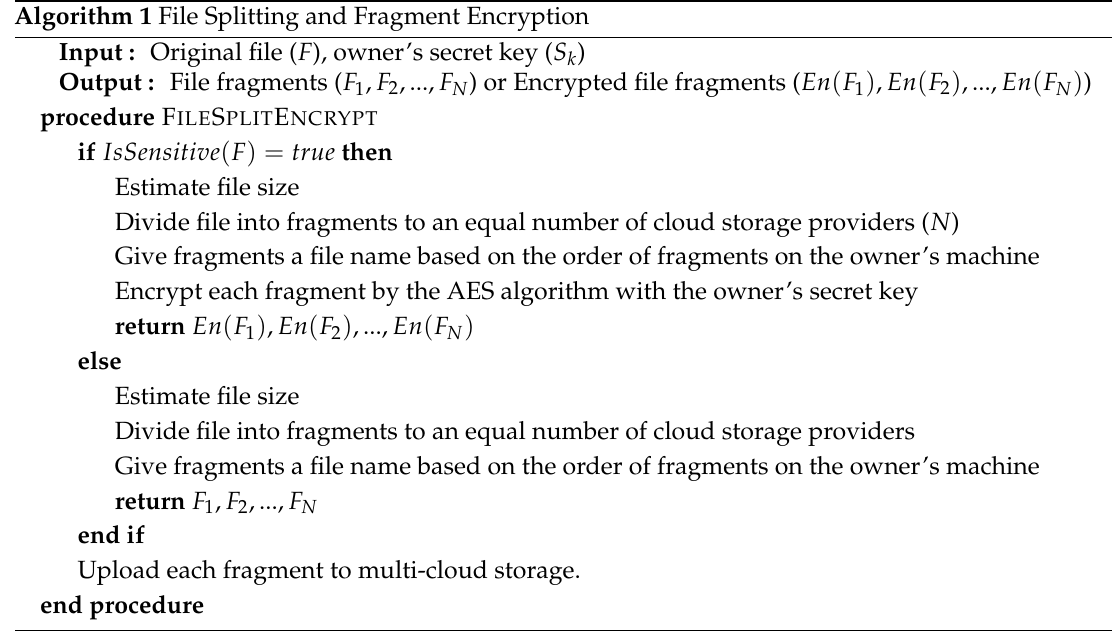
Algorithm 1 File Splitting and Fragment